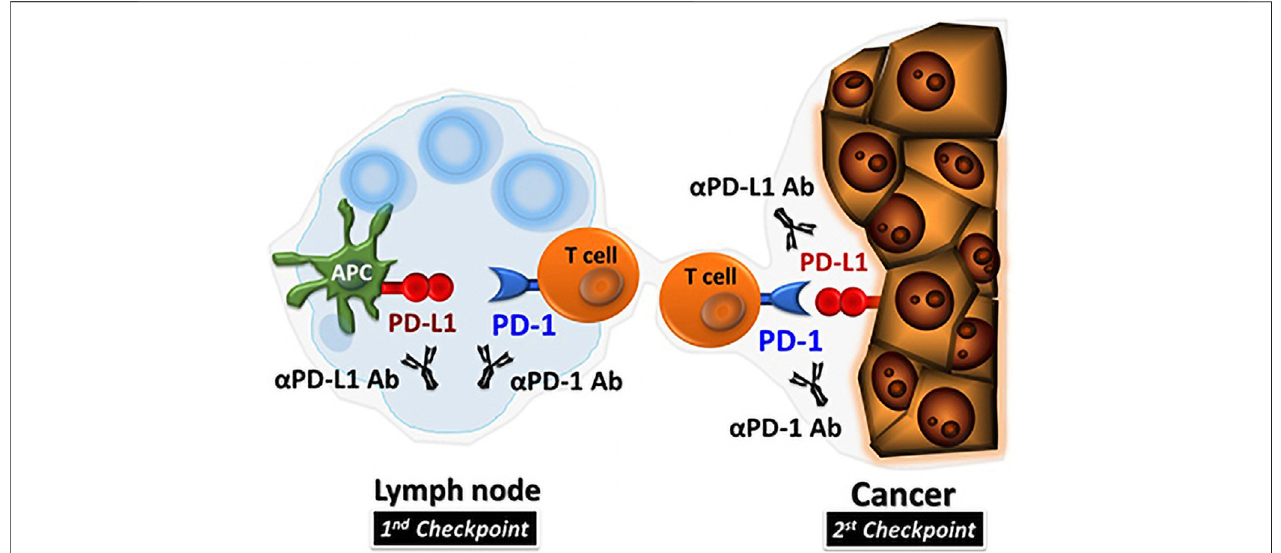
FIGURE 1 | PD1/PDL1 inhibitors in TME (Hamanishi et al., 2016).